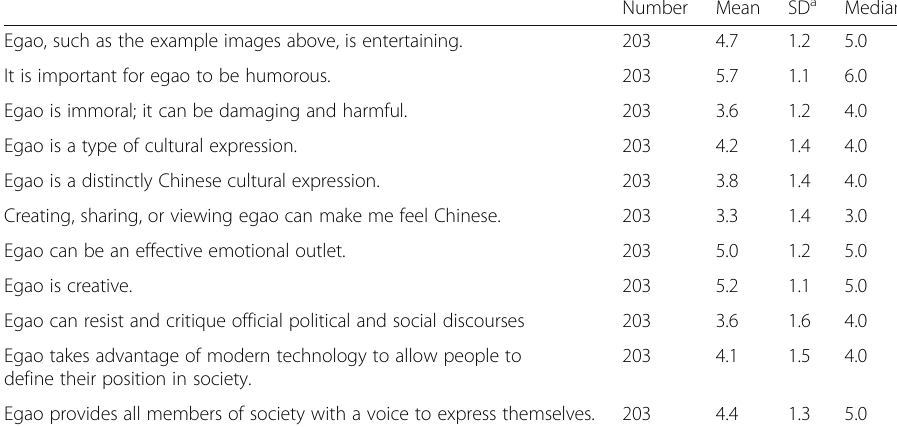
Table 2 Summary of survey